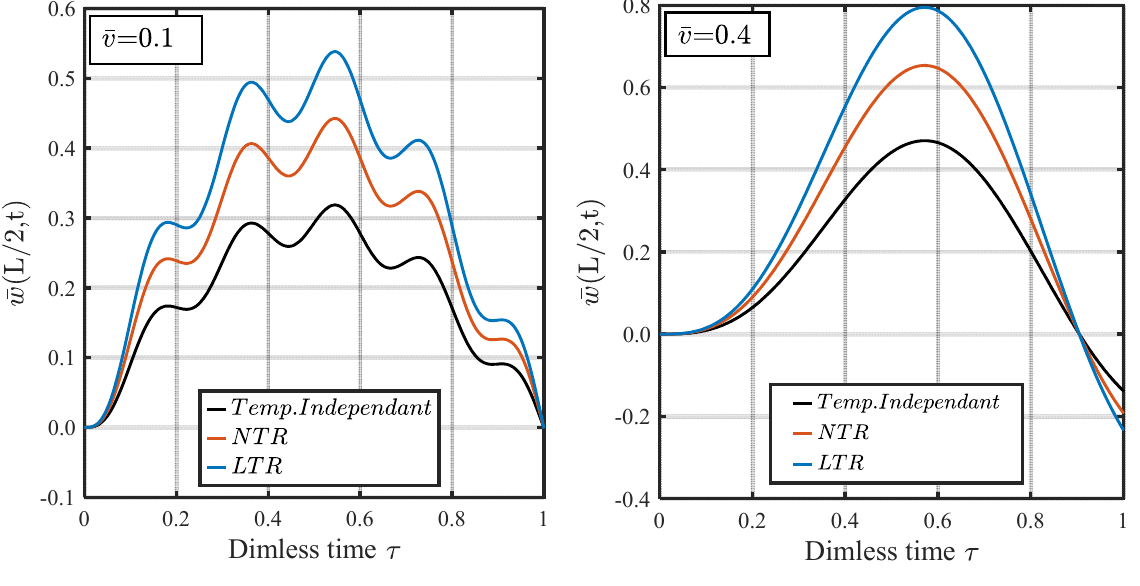
Figure 8. Influence of temperature distribution (temperature ‐ independent, LTR and NTR with (cid:2009) (cid:3021) (cid:3404) 2 ) on the dimensionless central deflection vs. time under a uniform moving load ( (cid:1863) (cid:3051) = (cid:1863) (cid:3053) = 0.2) at (cid:1874)̅ = 0.1, 0.4, and 0.8 and Δ(cid:1846) (cid:3404) 100